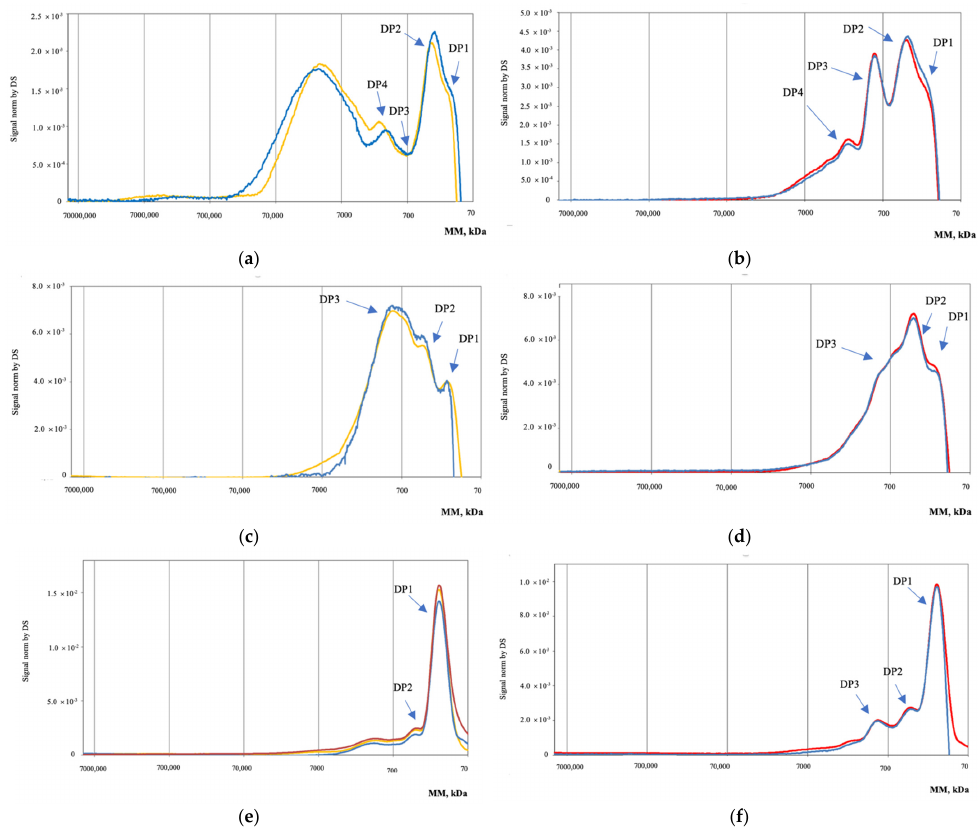
Figure 3. Common buckwheat molecular mass (MM, kDa) distribution identified using HPLC-SEC. Graph ( a )—buckwheat as control (BE Control); Graph ( b )—buckwheat as control after IND (BE Control IVD); Graph ( c )—batch I buckwheat flour enzyme-assisted extract (BE I); Graph ( d )—batch I buckwheat flour enzyme-assisted extract after IVD (BE I IVD); Graph ( e )—batch II buckwheat